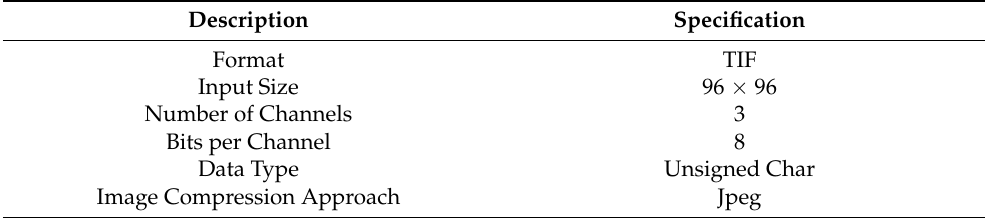
Table 2. Dataset descript associated with